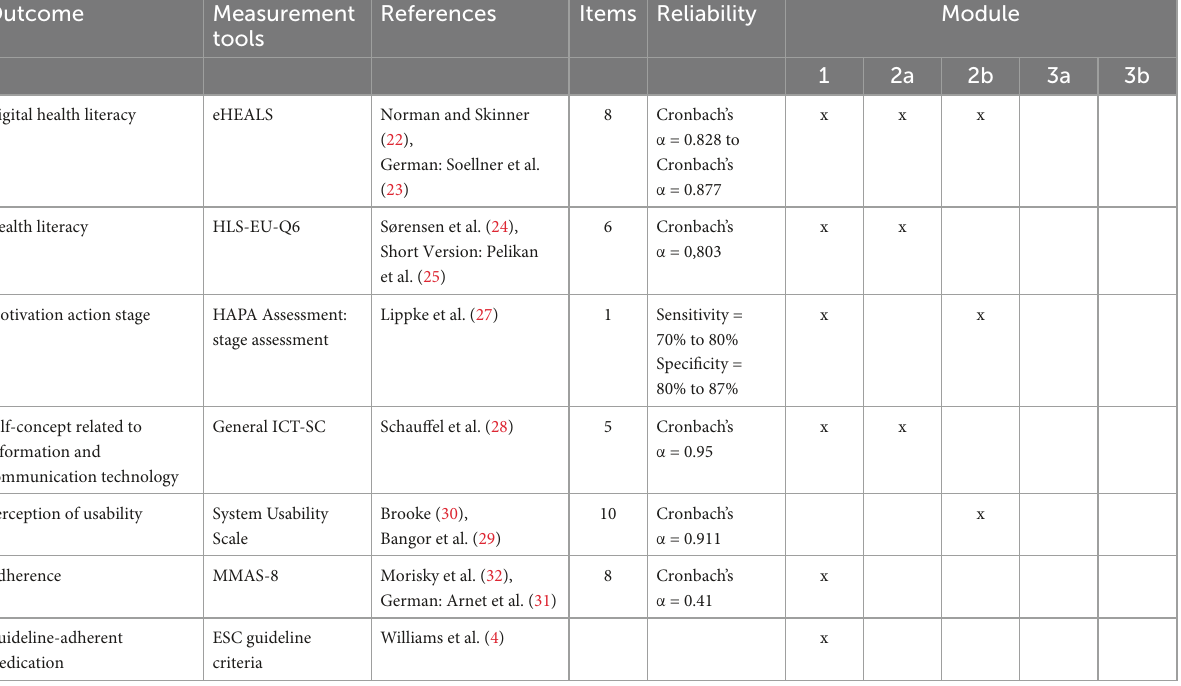
TABLE 3 Outcomes and measurement tools. Outcome Measurement